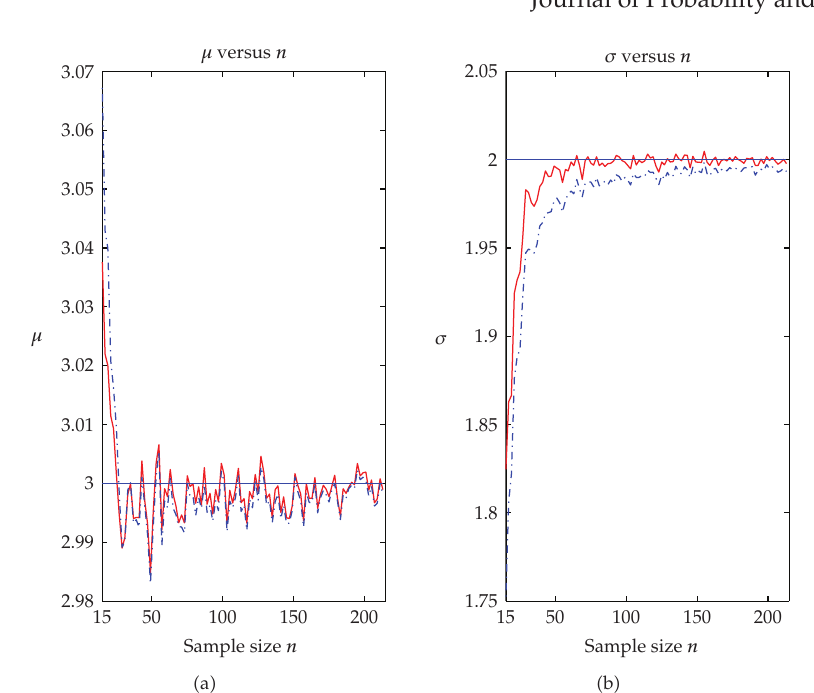
Figure 2: Grouped data: τ 1 (cid:8) 1 . 5, τ 2 (cid:8) 2 . 5, τ 3 (cid:8) 3 . 5, τ 4 (cid:8) 4 . 5, τ 5 (cid:8) 5 . 5. Type I left censored data: τ (cid:8) 1 . 5 .